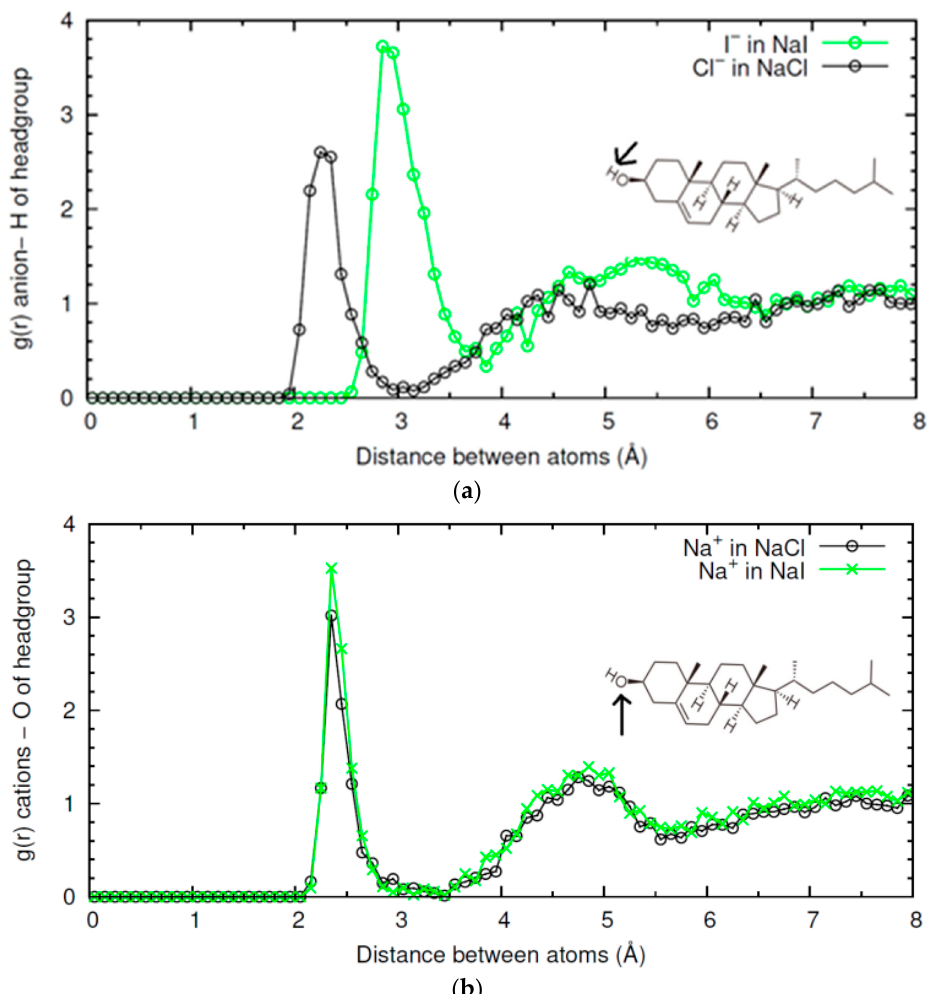
Figure 5. Radial distribution functions g ( r ) between NaCl or NaI ions and CHOL headgroup obtained in MD simulations ( T = 298 K) ( a ) g ( r ) between Cl − from NaCl (black open circles) or I − from NaI (green open circles) and H atom in -OH headgroup of CHOL; ( b ) g ( r ) between Na + from NaCl (black open circles) or NaI (green open circles), and oxygen atom in -OH headgroup of CHOL.